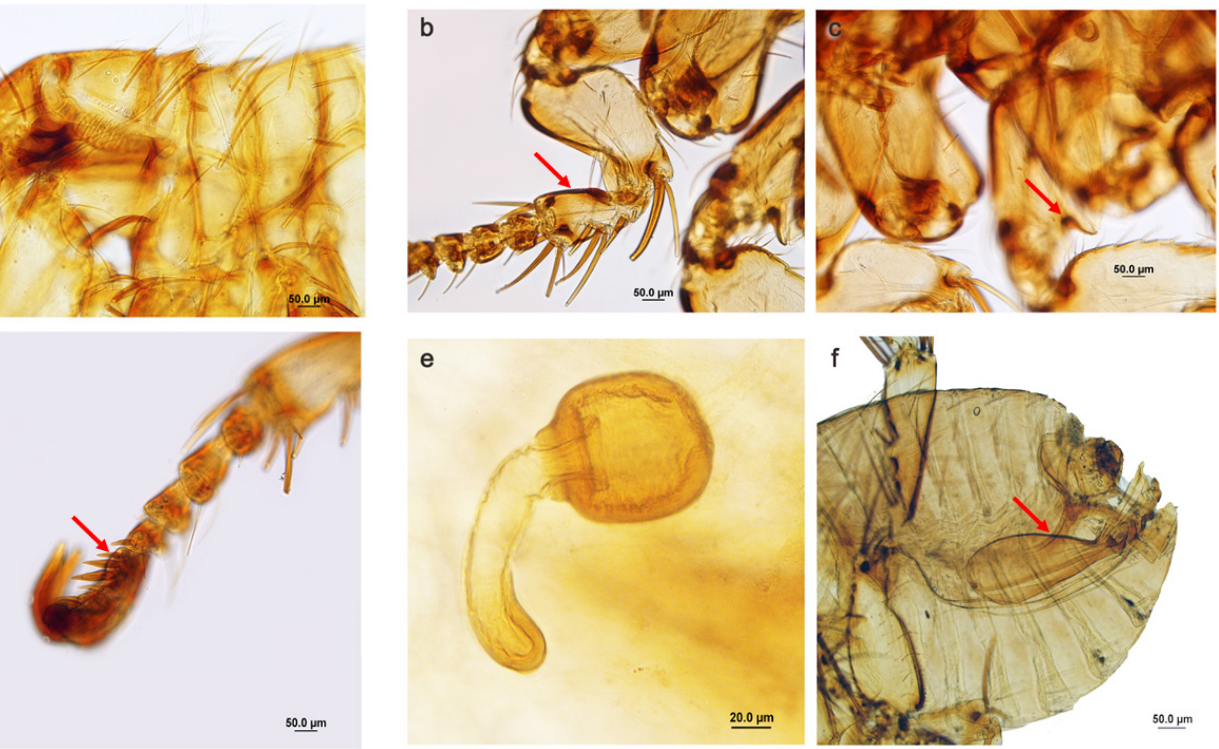
Figure 1. a–f : Phthiropsylla agenoris : ( a ) Details of the head and thorax; ( b ) details of fore tibia (arrow); ( c ) oblique break of mid coxa (arrow); ( d ) hindtarsus with distitarsomeres with 5 pairs of lateral plantar setae (arrow); ( e ) spermatheca; ( f ) male terminalia, paramere and aedeagus (arrow). 3.1.2. Polygenis (Polygenis) rimatus Description (males): Labial palp not reaching apex of fore coxa (Figure 2a); oblique break of mid coxa uncomplete (Figure 2b); acetabular seta below the level of the upper margin of acetabulum; distal arm of ninth sternum laterally with setae extending two − thirds the distance from the apex; angle between distal and proximal arms of the basal part of aedeagal tubus about 90 ◦ ; coil of aedeagal inner tube making 2.5 turns (Figure 2c). Unfortunately, we could not find female specimens of P. (P.) rimatus in this study in order to compare the main morphological traits between the two taxa.